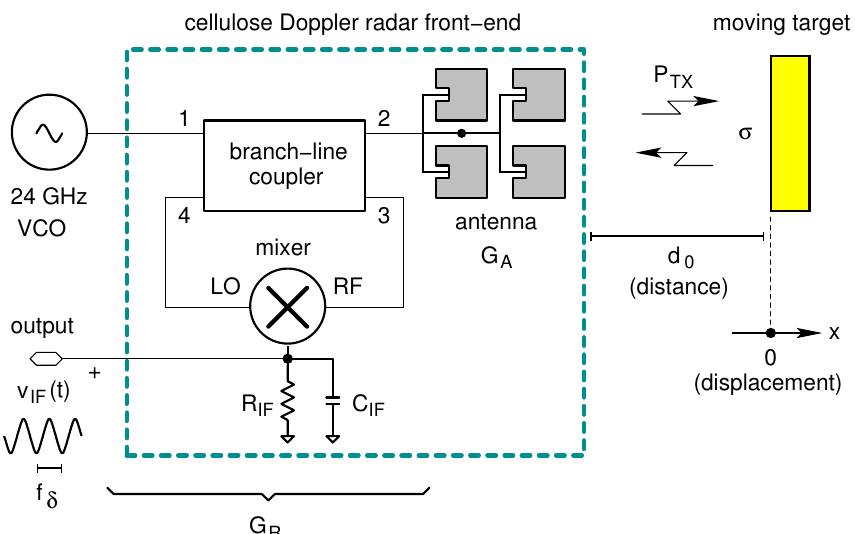
Figure 1. Block diagram of the radar sensor. The circuit uses a branch-line power divider to couple the voltage-controlled oscillator (VCO) to both the antenna and the mixer. If the target moves, a Doppler frequency shift f δ is produced in the reflected wave and is detected by the mixer circuit. The resistance R IF and the capacitor C IF constitute a low-pass filter and terminate the mixer output port. LO: local oscillator; RF: radio